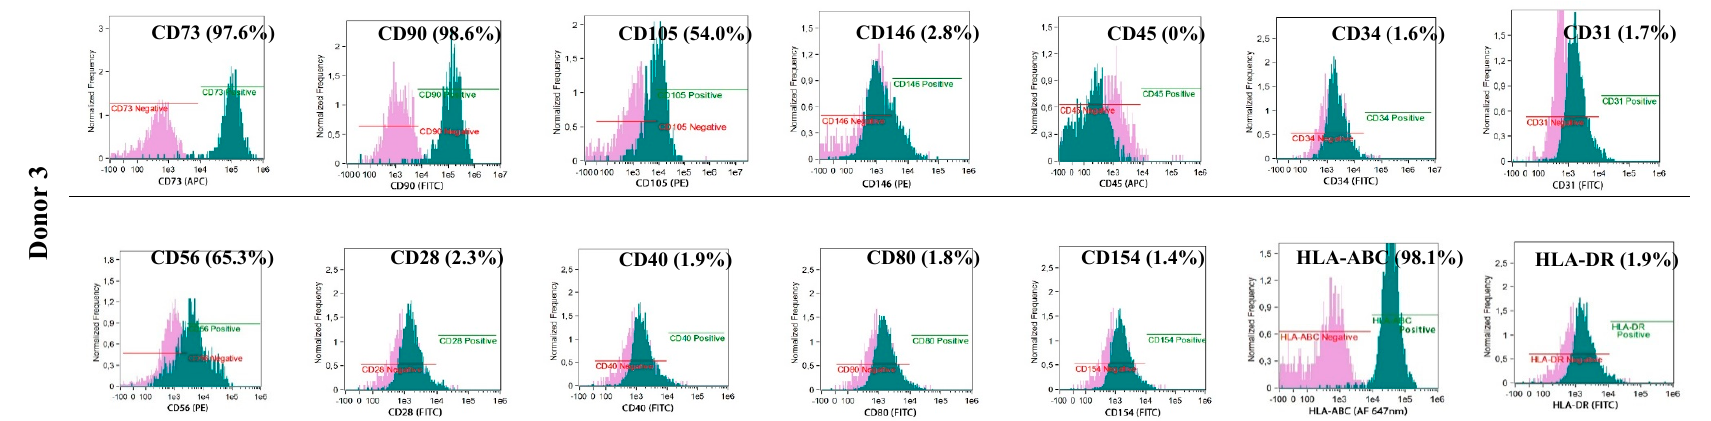
Figure 5. Phenotype of myogenic stem / progenitor cells isolated from the donor’s skeletal muscles. Isolated myogenic stem / progenitor cells show the basic naïve MSC phenotype CD73 +/ CD90 +/ CD105 + , proangiogenic properties CD146 + , expression of HLA-class I antigens, low expression of HLA-DR antigens, low number of cells expressing co-stimulatory molecules CD28, CD40, CD80, CD154 and lack of the hematopoietic phenotype CD45. Myogenic stem / progenitor cells express the specific phenotype CD56.